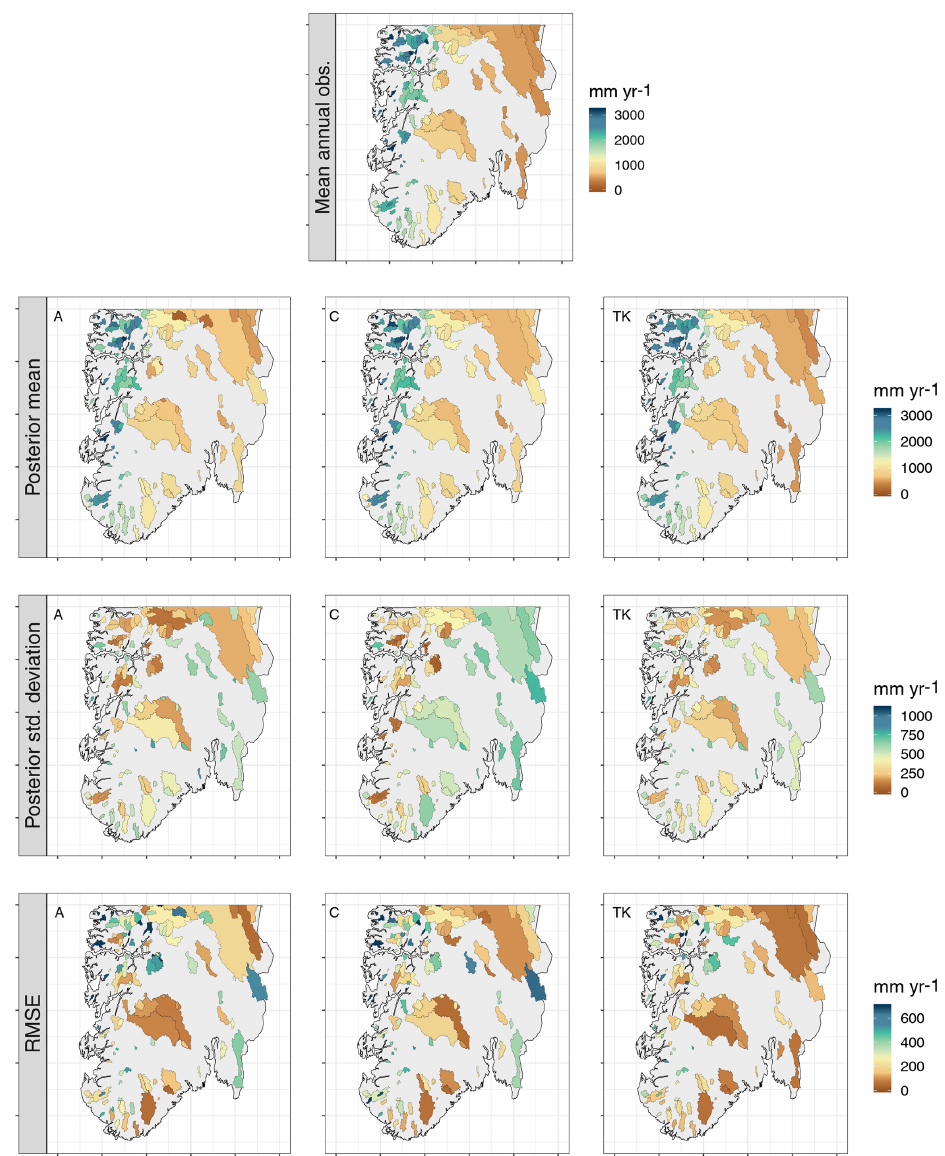
Figure 7. Average posterior mean for Q j ( A ) , average posterior standard deviation for Q j ( A ) and average RMSE for each catchment for predictions of missing annual observations in southern Norway for j = 1 ,..., 10 for the areal model (A, left), the centroid model (C, middle) and top-kriging (TK, right) when the target catchments are treated as ungauged (UG). The observed mean annual runoff is also included as a reference (first